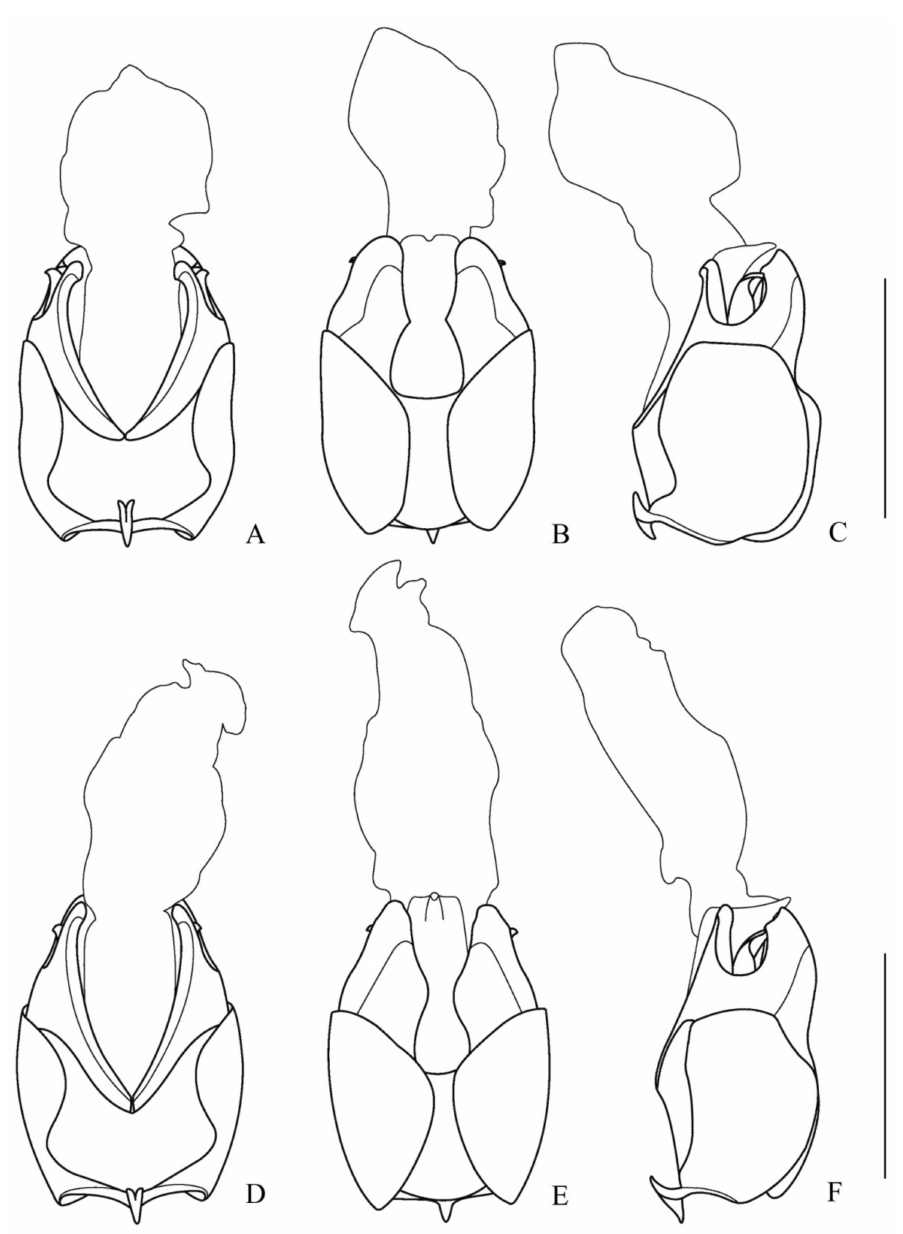
Figure 5. Aedeagus ( A , D ) ventral view; ( B , E ) dorsal view; ( C , F ) lateral view): ( A – C ) Lycocerus daliensis sp. nov. ; ( D – F ) L. vietnamensis sp. nov. Scale bars: 1.0